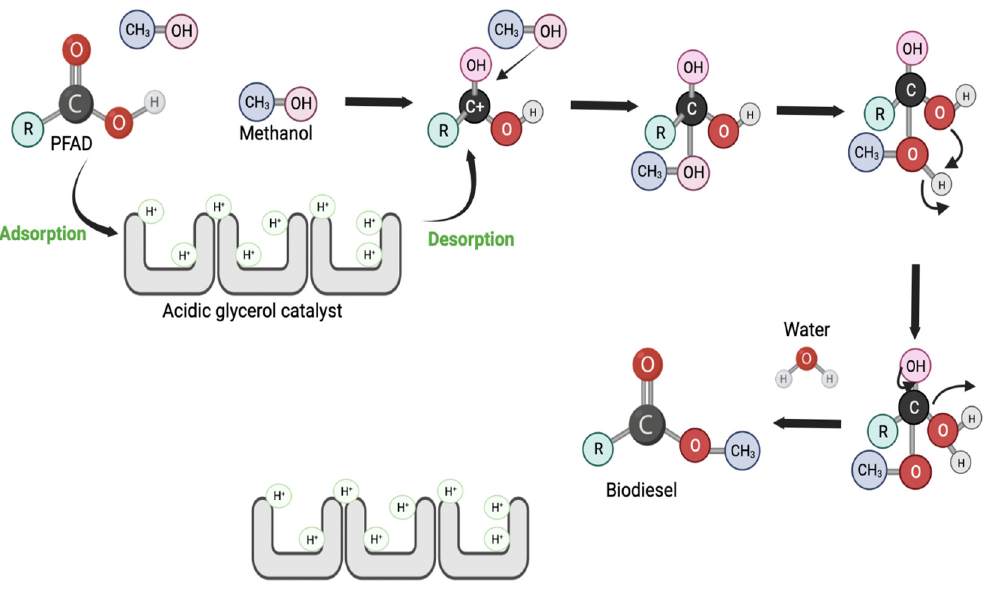
Figure 8. Proposed mechanism of PFAD-methanol esterification with acidic glycerol.